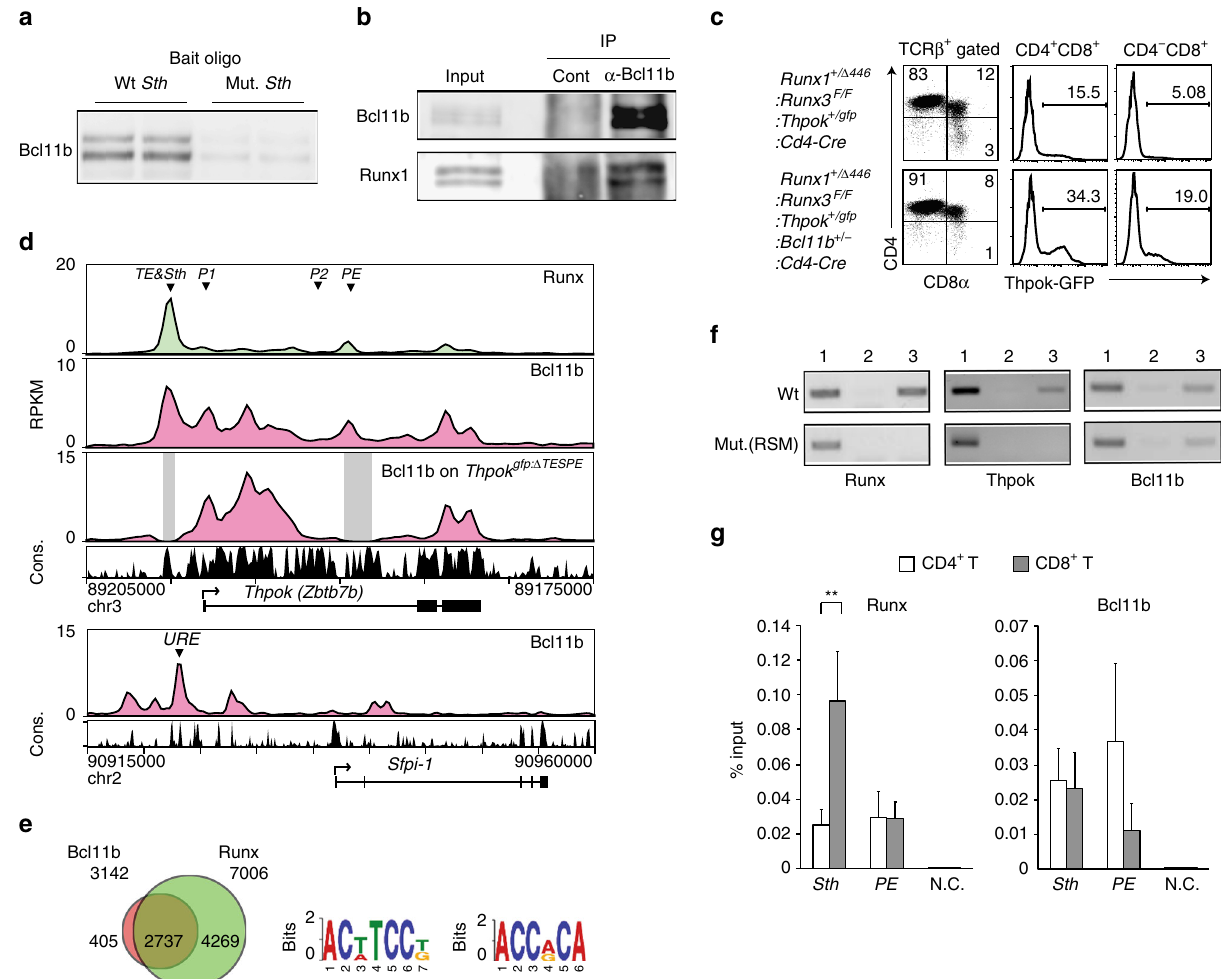
Fig. 1 Binding of Bcl11b to regulatory regions in the Thpok gene. a DNA pull-down assay showing in vitro Bcl11b binding to wild-type (Wt) Thpok silencer ( Sth ) core sequences, but not ef fi ciently to mutant (Mut.) sequences. One representative of two experiments. b Co-immune precipitation assay showing interaction of Bcl11b with Runx1. One representative of two experiments. c Flow cytometry showing an increase of CD8 + T cells de-repressing Thpok-GFP upon reduction of Bcl11b dosage in Runx mutant mice. One representative of two independent experiments. d Bcl11b ChIP-seq tracks at the Thpok , Thpok gfp: Δ TESPE , and Sfpi1 genes in total thymocytes along with Runx ChIP-seq (GSE90794) tracks at the Thpok gene ( top ) for reference. Gene structure, transcriptional orientation and conservations in mammals (Cons.) in the Thpok gene are indicated. Positions of Thpok silencer ( Sth ), two enhancers ( TE and PE ), distal P1-promoter ( P1 ) and proximal enhancer ( PE ) in the Thpok gene, and upstream regulatory element ( URE ) in the Sfpi1 gene are indicated as arrowheads . e Co-occupancy by Runx at Bcl11b-bound genome regions. Runx recognition site (5 ′ -ACCPuCA-3 ′ ) was listed among the top two common sequences for Bcl11b-bound regions. f ChIP-PCR assay for binding of Runx, Bcl11b, and ThPOK to Wt and Runx site mutated (RSM) Sth regions in CD4 + T cells from Thpok + /gfp:241-401RM mice. Lanes 1, 2, and 3 are input, control IgG and antibody-against the indicated transcription factor, respectively. One representative of two independent experiments. g ChIP-qPCR analyses showing binding of Runx and Bcl11b to the Sth and PE in CD4 + (white bars) and CD8 + (gray bars) T cells. Combined data from three independent ChIP experiments is shown. ** P < 0.01 (unpaired t